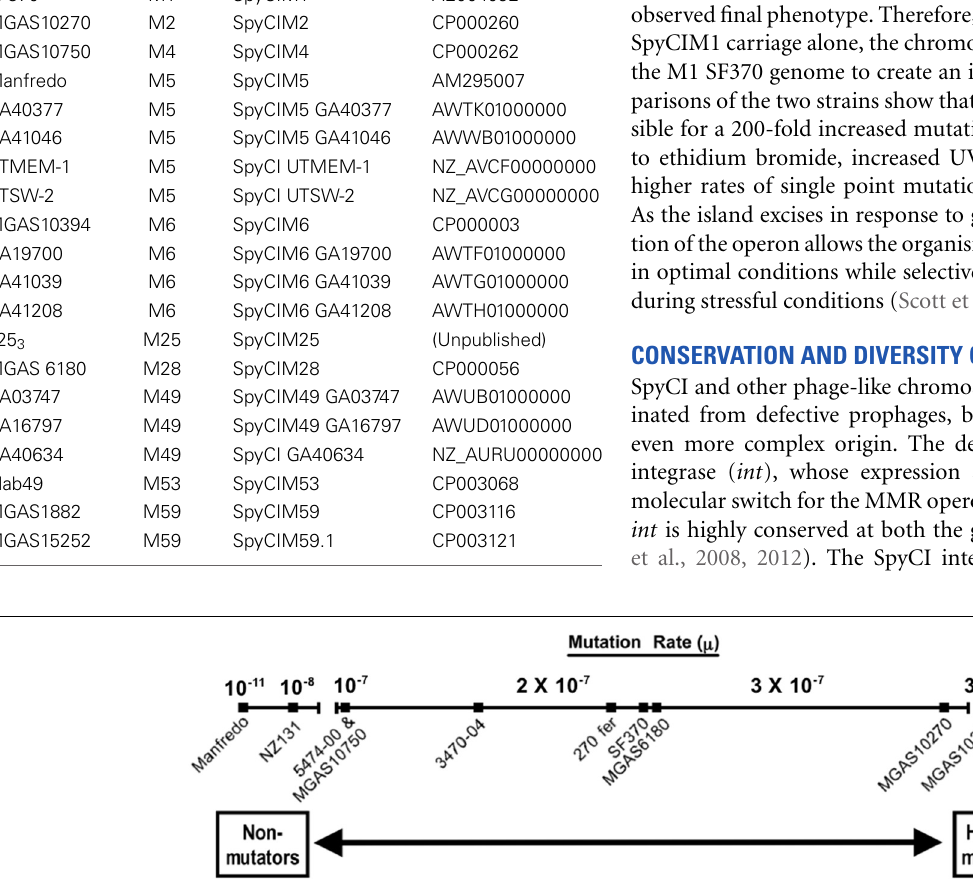
Frontiers in Cellular and Infection